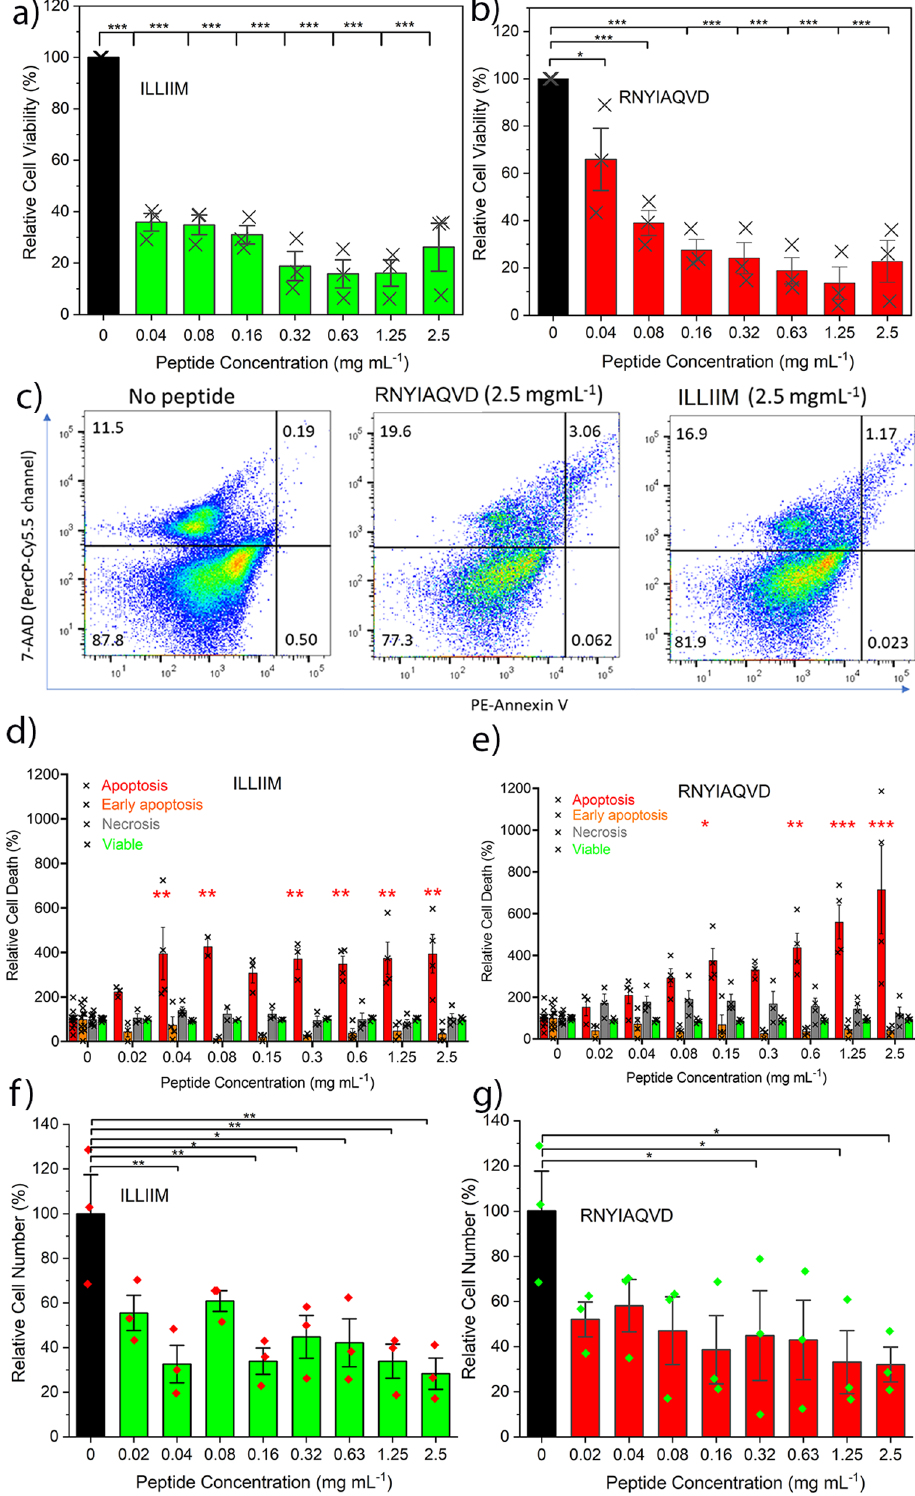
Fig. 5 Cell metabolic and viability assays of ILLIIM and RNYIAQVD assemblies over a range of concentrations. a , b MTT assays showing cell viability after 48h incubation on cultured SH-SY5Y cells normalised to cells grown in the absence of peptide. c Representative fl ow cytometry plots of SH-SY5Y cells after 48h culture with the amyloid assemblies, plots are split into four quadrants bottom left: viable, bottom right: early apoptosis, top left: necrotic, top right: late-stage apoptosis. d , e Quanti fi cation of cell death/viability pathways over a range of peptide assembly concentration normalised to cells grown in the absence of peptide (statistics are all relative to the no peptide control, and the result of at least three independent experiments). f , g Manual cell counts performed after 48h incubation showing relative cell number compared to cells grown in the absence of peptide. For all panels, the error bars represent the standard error of mean of three biologically independent experiments ( n = 3). Statistical analysis performed by one-way ANOVA with Tukey comparison. * p < 0.1, ** p < 0.01, *** p < 0.001. Values of p are given in Supplementary Table 2. FACS gating strategy given in the Supplementary information. NATURE COMMUNICATIONS| (2022) 13:3387 |https://doi.org/10.1038/s41467-022-30932-1|www.nature.com/naturecommunications